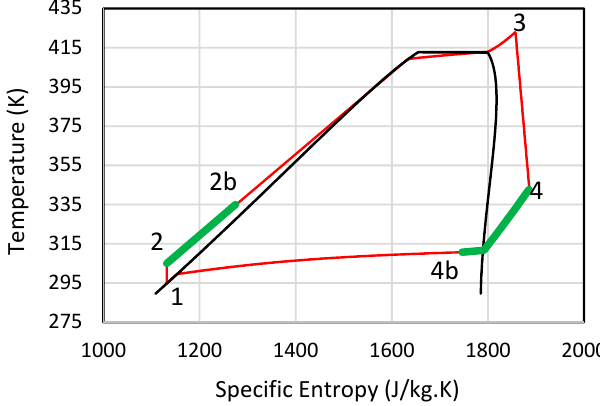
Figure 2. T-s diagram of a zeotropic ORC, with the recuperative portion of the cycle marked in a thicker green line.